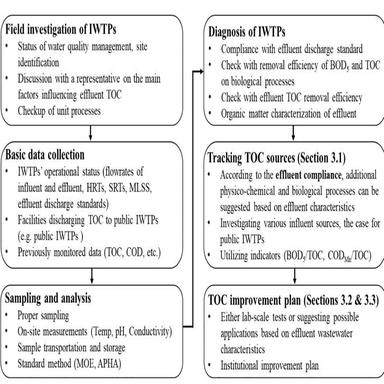
Schematic diagram of TOC investigation for industrial wastewater treatment plants (IWTPs).